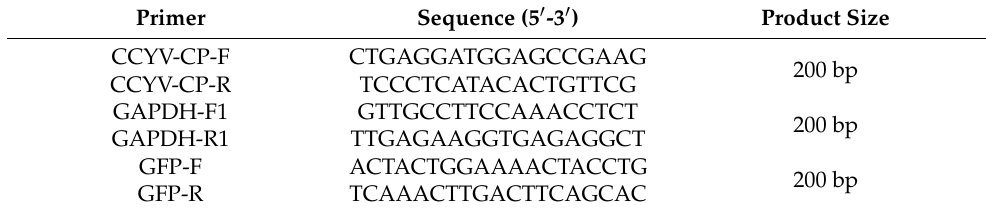
Table A1. Primers used for RT-qPCR